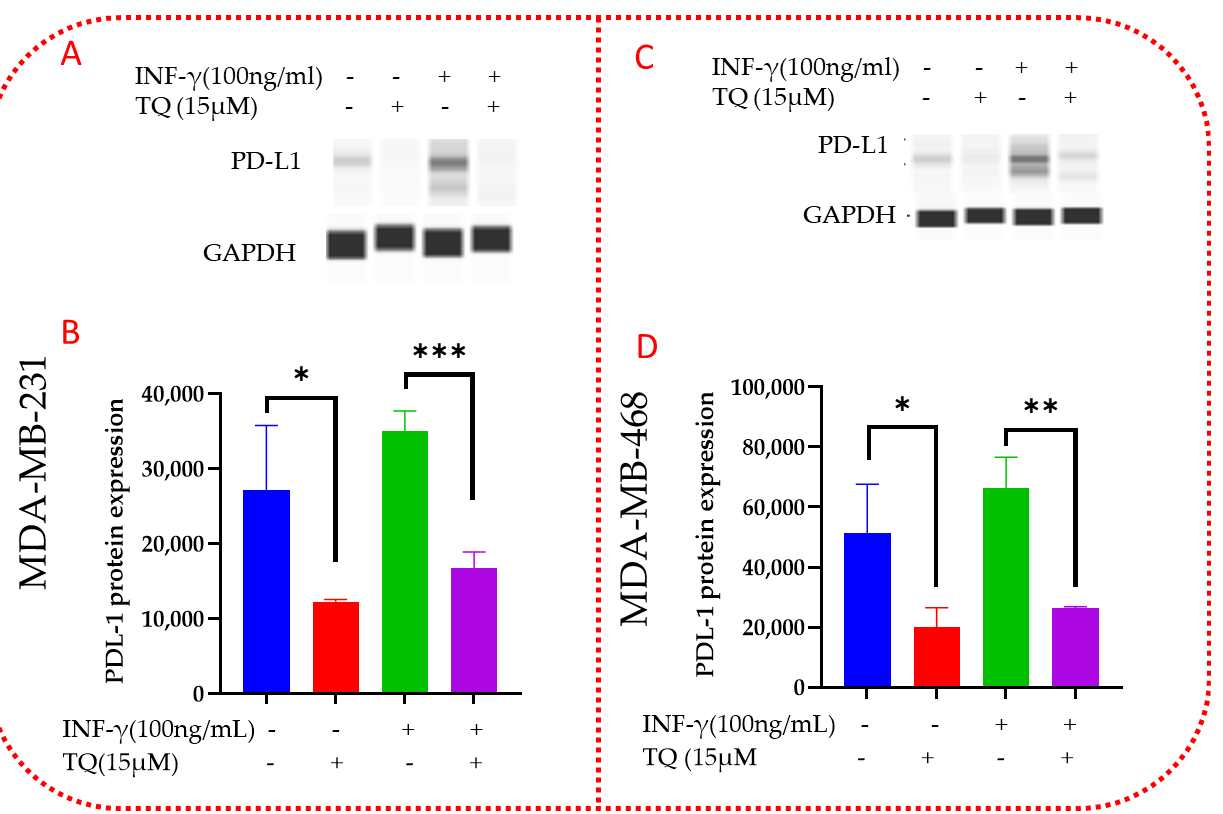
Figure 12. TQ modulatory effect on PD-L1 protein expression in MDA-MB-231 and MDA-MB-468 TNBC cells after 24 h treatment. Western analysis was used to evaluate the expression of the PD-L1 protein, MDA-MB-231 ( A , B ), and MDA-MB-468 ( C , D ). ( A , C ) shows blot view cropped from Compass software corresponding to the protein expression after exposure to the treatments. ( B , D ) show a bar graph depicting total PD-L1 expression after the following treatments: control, TQ, INF-γ, and TQ + INF-γ, respectively. TQ and INF-γ and INF-γ vs. TQ + INF-γ were evaluated for statistical significance using one-way ANOVA and Dunnett’s multiple comparison tests. * p < 0.05, ** p < 0.01, *** p < 0.001.